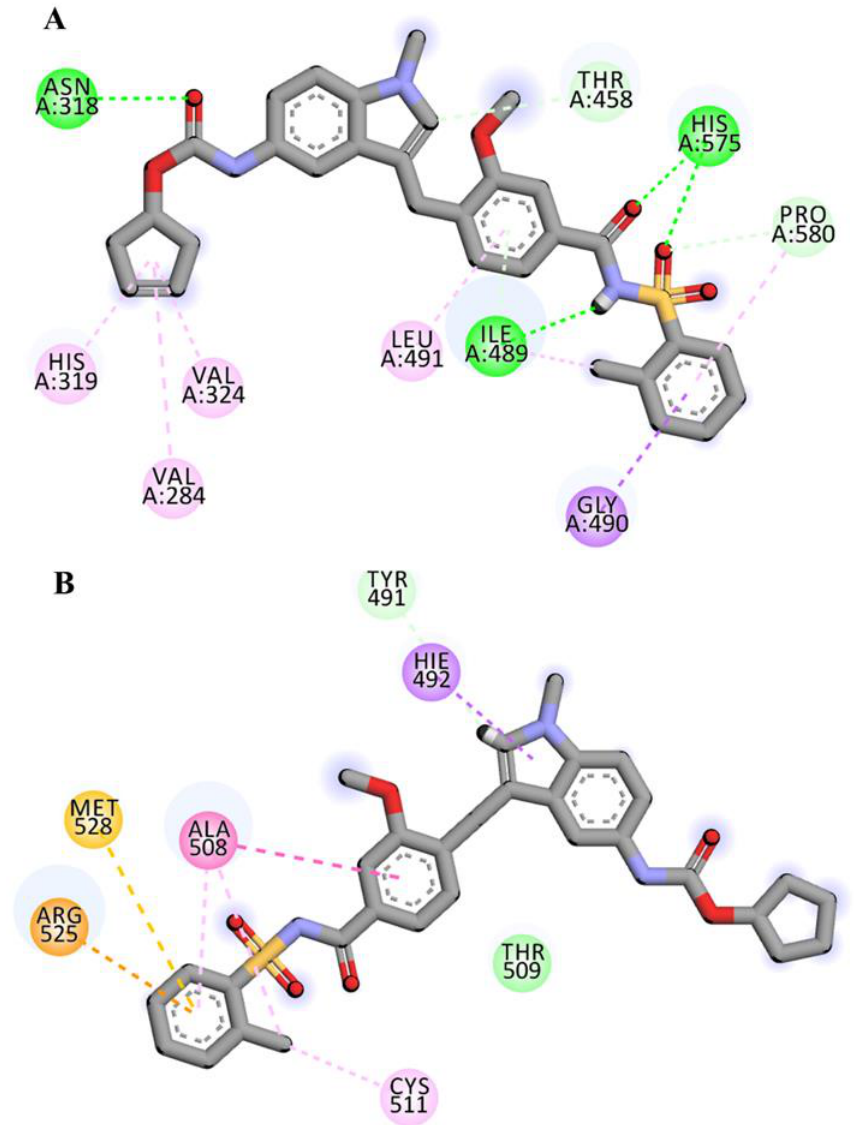
Figure 11. 2D representation of complex-2 before ( A ) and after ( B ) the simulation run of 100 ns. The ligand has been colored by element where grey represents carbon atoms, red corresponds to oxygen atoms, purple shows nitrogen atoms and yellow indicates sulfur atom.